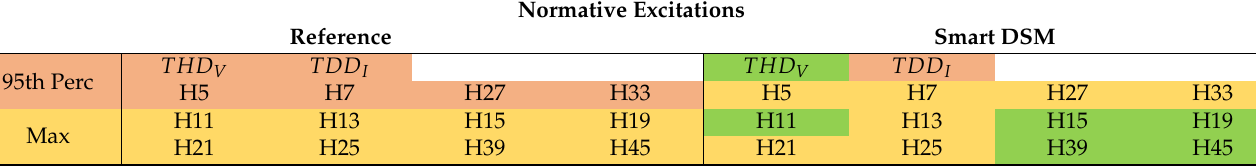
Table 5. Excitations of the normative limits for the reference case and the optimized grid for the industrial application. Marked in red are the normative limit violations (for harmonics and THD V from EN 50160/61000-2-2, for TDD I from IEEE 519) for the 95th percentile of the values during the time interval of one day, in yellow the limit violations only for the maximum values and in green the values in accordance to their respective limits. The THD V was the main objective of the